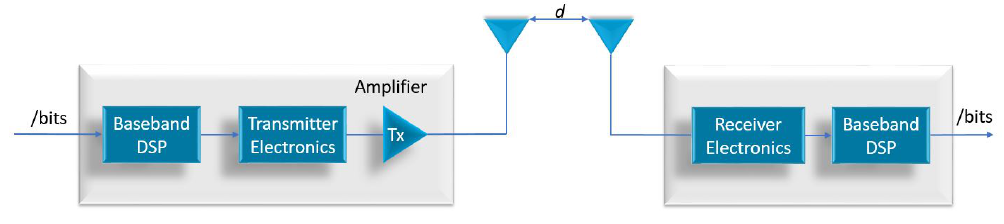
Figure 11. A single hop wireless